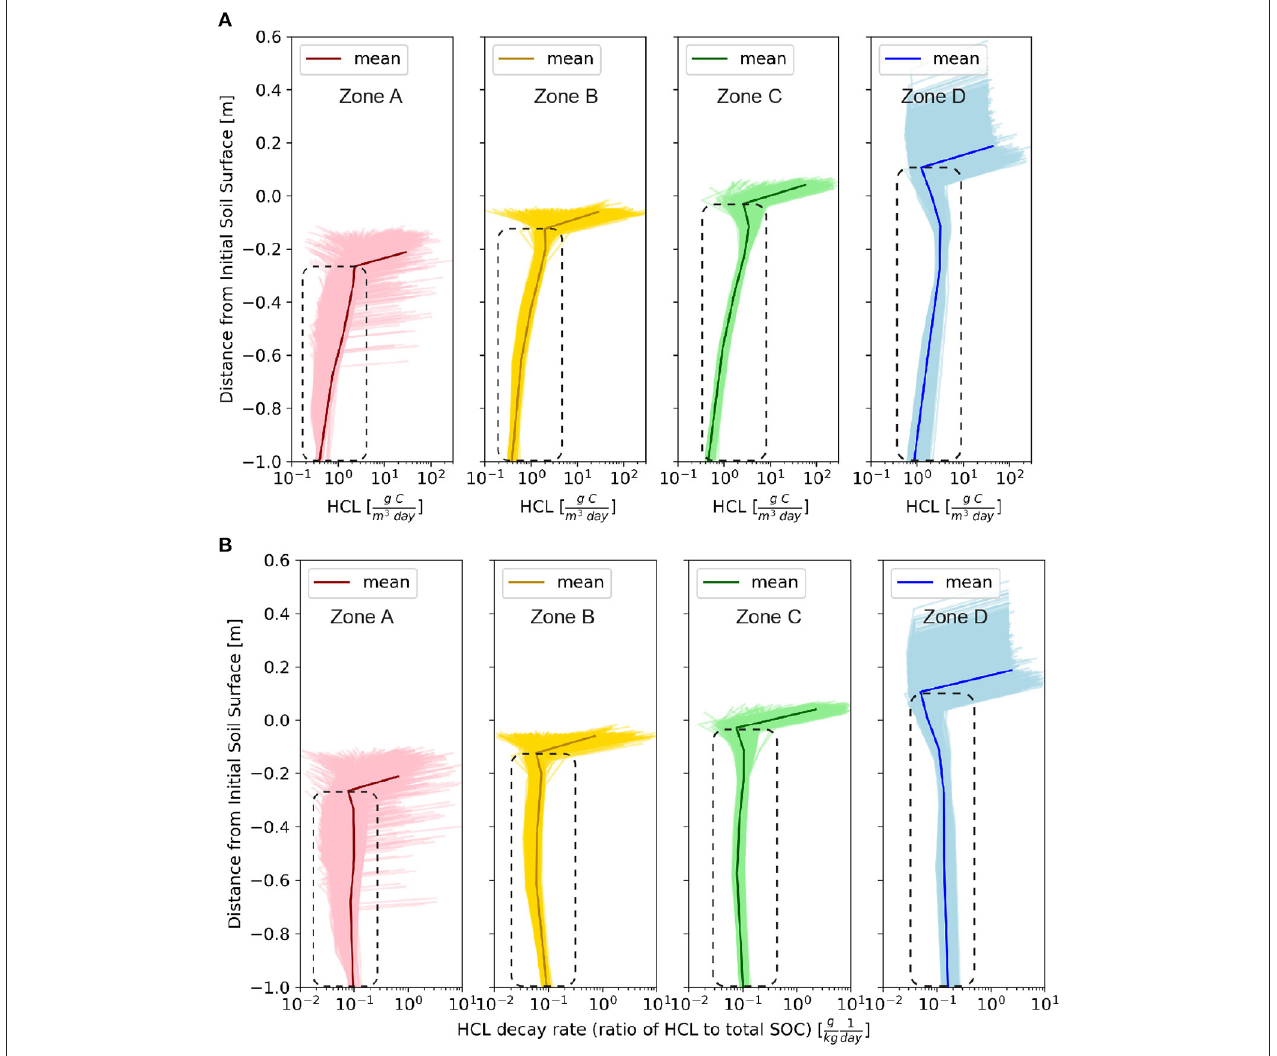
FIGURE 5 | The vertical profiles of daily mean values at a dynamic steady-state condition at 85 years. The dash box corresponds to below-surface layers. (A) The HCL at a dynamic steady-state condition at 85 years. (B) The decay rates D r (the ratio of heterotrophic carbon loss to the total SOC).